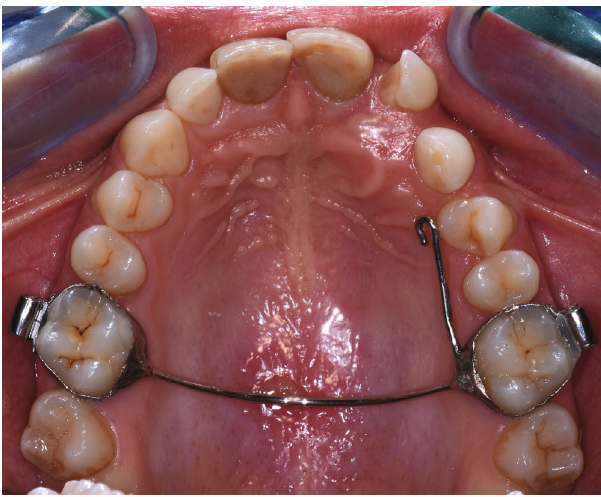
Figure 2: Intraoral photo with the TPB cemented to the fi rst molars and the orthodontic traction hook